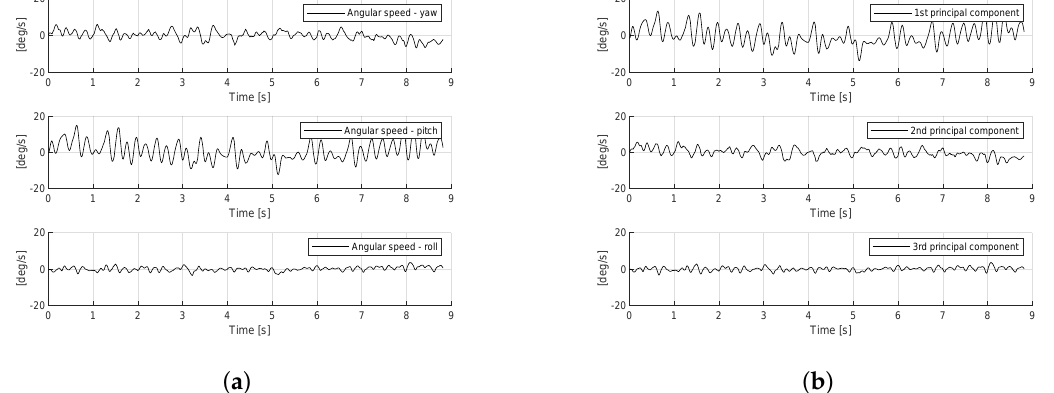
Figure 5. Gyroscope signal measured at the head of a patient with cervical dystonia (Patient-48). ( a ) measured signal from triaxial gyroscope; ( b ) principal components of the measured